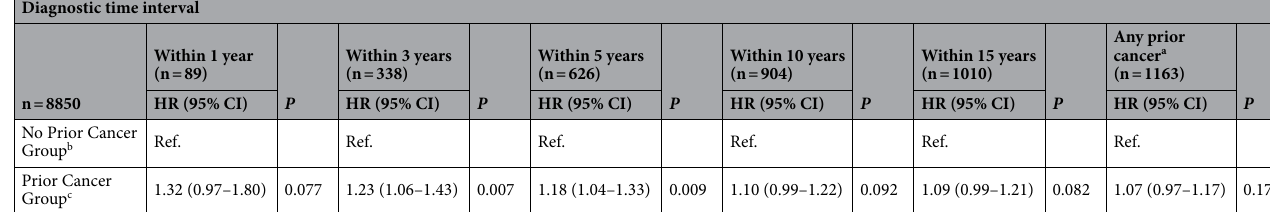
Table 2. Impact of prior cancer on survival in NSCLC patients according to diagnostic time interval. HRs were calculated using Cox proportional hazards models on all-cause mortality in NSCLC patients stratified by diagnostic time interval (1, 3, 5, 10, and 15 years) between the most recent prior cancer and the index cancer. The models adjusted for the following covariates measured at the index NSCLC diagnosis: age divided by 10, sex, method of cancer detection, treatment, body mass index, Barthel Index, Charlson Comorbidity Index, interstitial lung disease, tyrosine kinase inhibitor use, smoking status, diagnosis year, and Area Deprivation Index. The No Prior Cancer Group was used as the reference category. CI Confidence interval, HR Hazard ratio, NSCLC non-small cell lung cancer. a Prior cancer regardless of diagnostic time interval. b Patients without any history of prior cancer prior cancer. c Patients with a history of prior cancer.